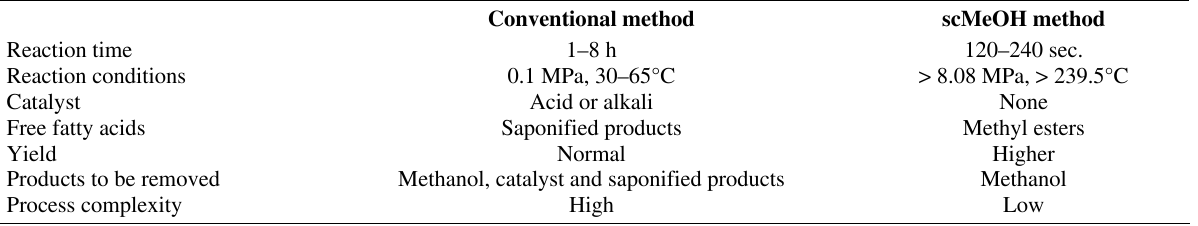
Table 1 . Comparison between the conventional method and the supercritical methanol method for biodiesel production